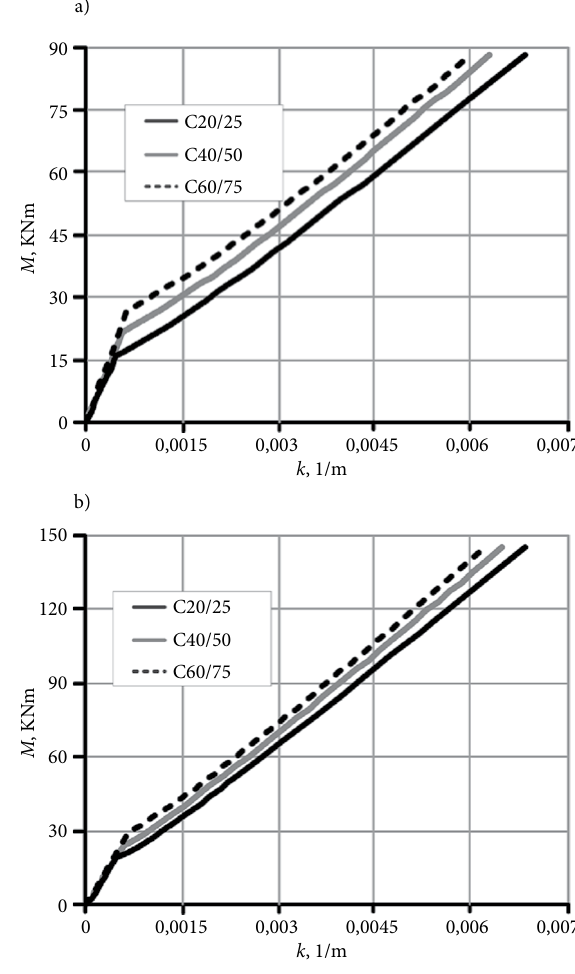
Fig. 1. Moment-curvature diagrams of ranging reinforcement ratio: a - grade of concrete C20/25; b - grade of concrete